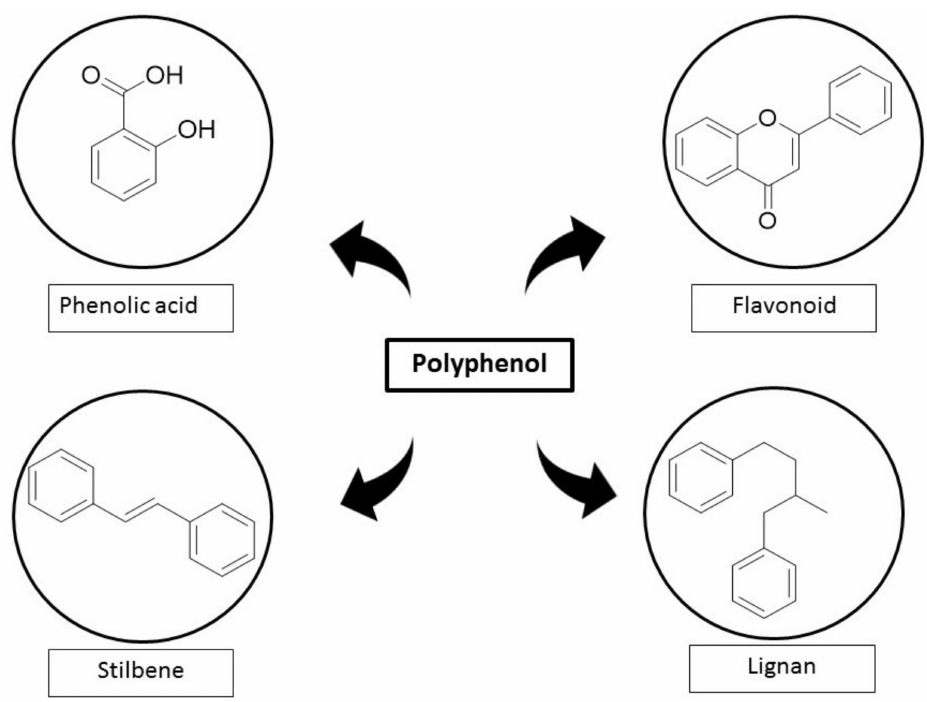
Figure 3. The different types of polyphenol classes’ chemical structure including phenolic acid, flavonoid, stilbene and